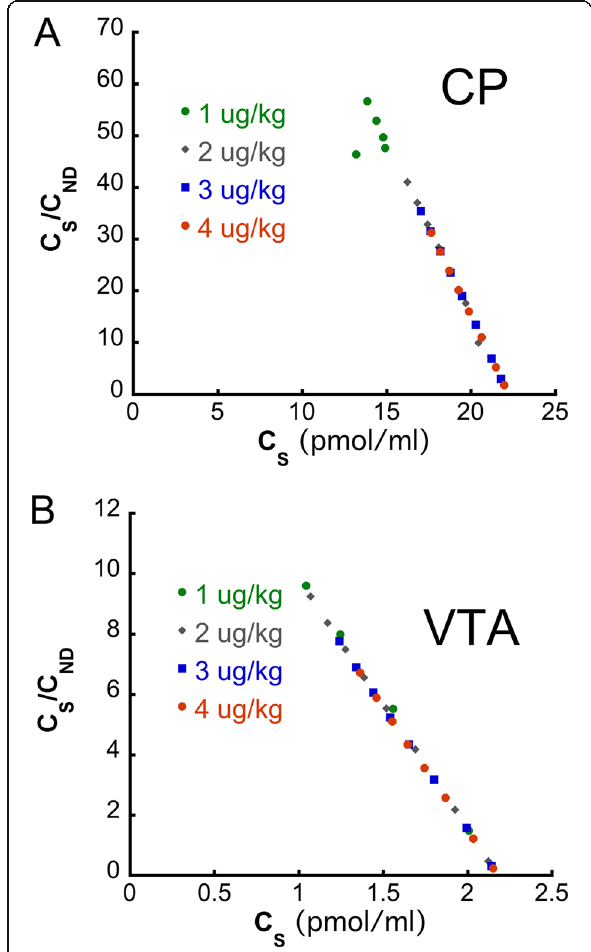
Fig. 2 Scatchard plots of the simulation study in the a CP (a high- binding VOI) and b VTA (a low-binding VOI) for various masses of the injected unlabeled ligand. Note that a dose of the unlabeled ligand of 3 ug/kg or higher produces a Scatchard plot in both VOI. The dose of 3 ug/kg produces a Scatchard plot with the highest range of C S /C ND values